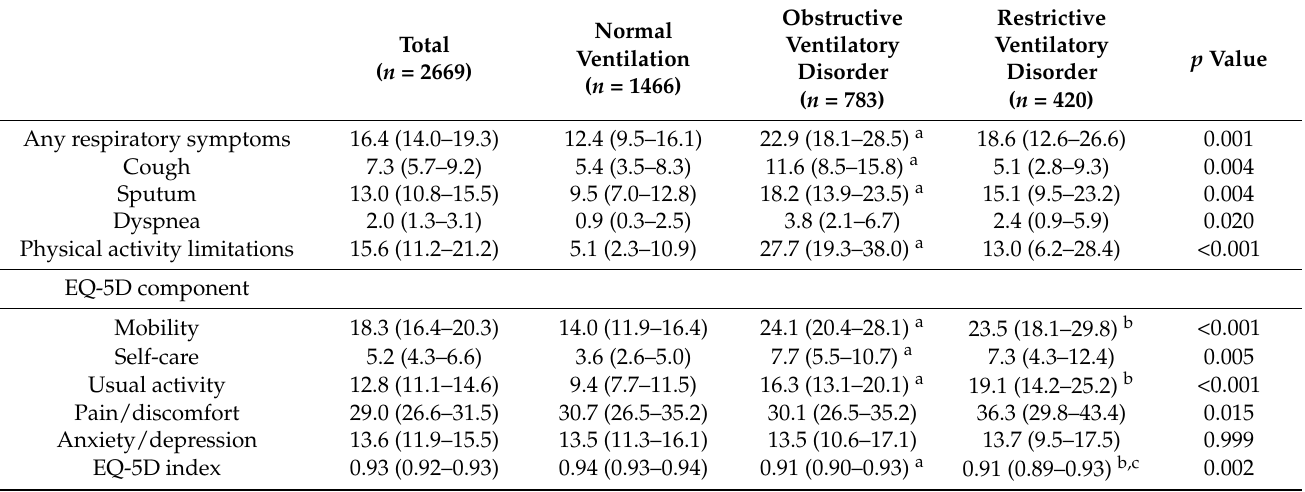
Table 2. Comparison of symptoms, physical activity, and quality of life according to spirometric